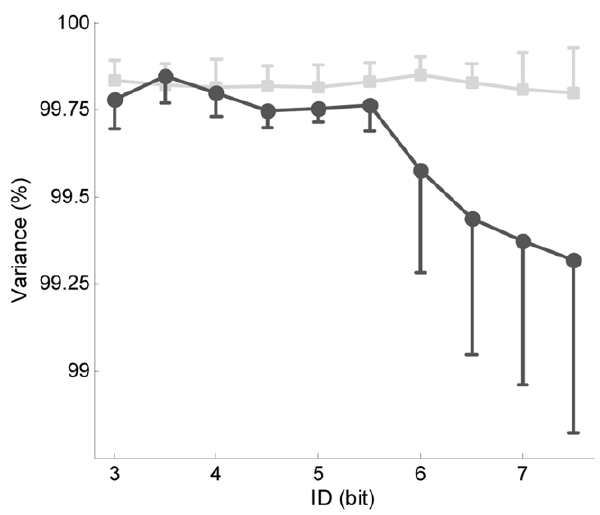
Figure 2. PCA analysis results. Variance captured by the first mode for AT (square markers, light grey line) and DT (round markers, dark grey line).